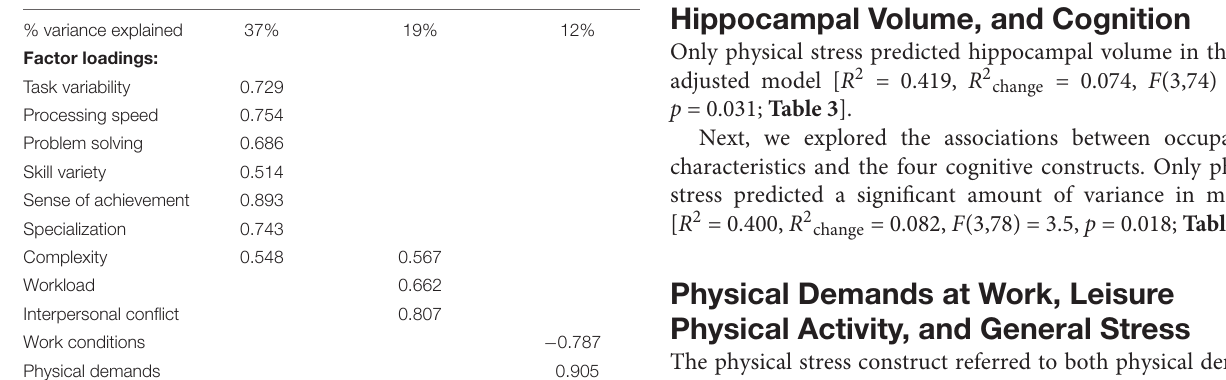
TABLE 2 | Results of factor analysis with PCA on select occupational characteristics. Job complexity Psychological stress Physical